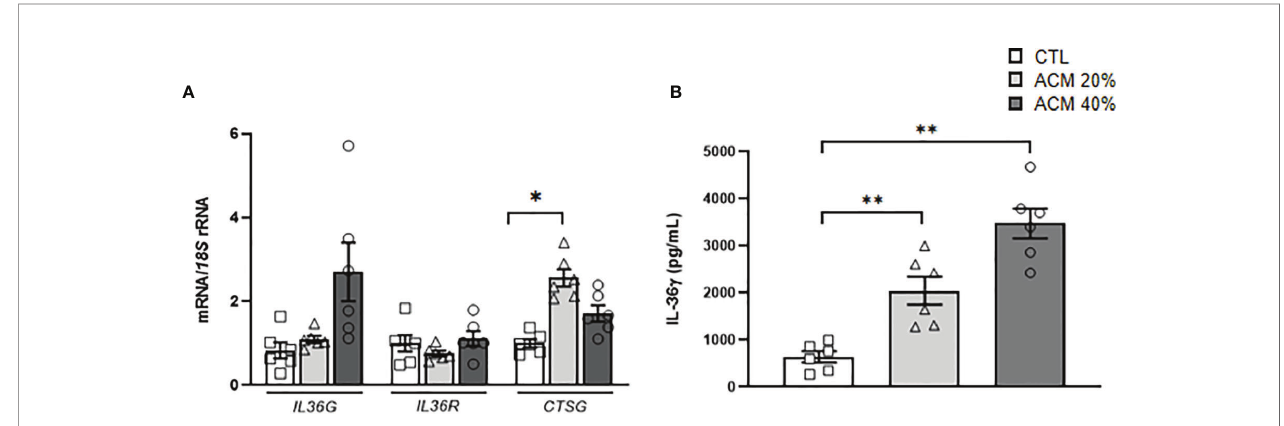
FIGURE 4 | Effects of adipocyte-conditioned media (ACM) in monocytes-derived macrophages. Bar graphs show the effect of ACM (20 and 40%) from subjects with obesity incubated for 24 h on the transcript levels of (A) IL36G , IL36R and CTSG and (B) secreted levels of IL-36 g after ACM treatment. Values are the mean ± SEM (n=5-6 per group). Differences between groups were analyzed by one-way ANOVA followed by Tukey ’ s tests. * P < 0.05 and ** P < 0.01. (n=5-6 per